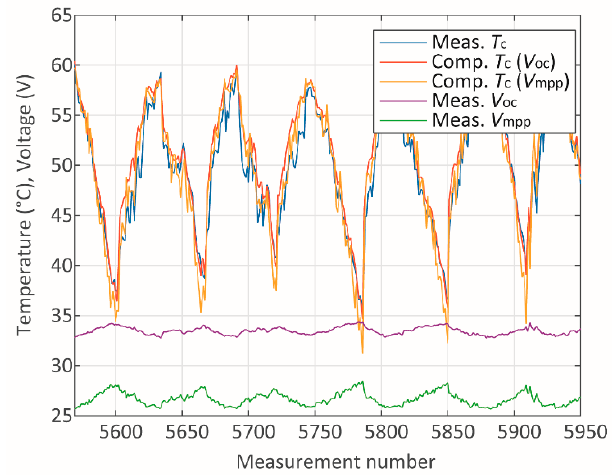
Figure 6. Temperature and voltage during clear-sky days.